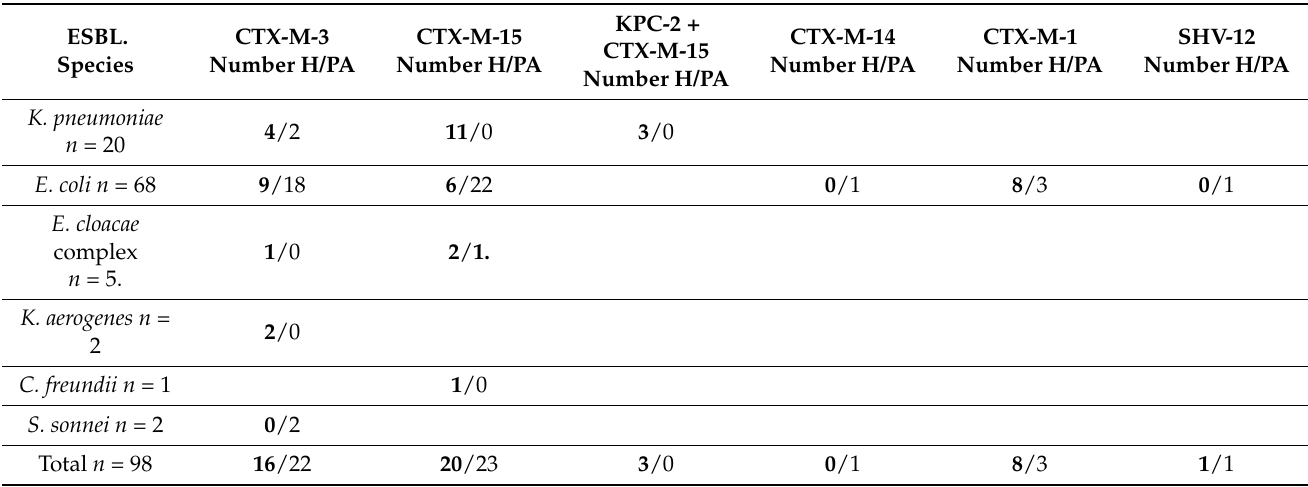
Figure 1. Antimicrobial susceptibility rates in the whole group of Enterobacterales isolates ( n = 98), E. coli ( n = 68), and K. pneumoniae ( n = 20). Abbreviations: CTX, cefotaxime; AUG, amoxicillin/clavulanic acid; CAZ, ceftazidime; FEP, cefepime; FOX, cefoxitine; IMP, imipenem; P/T, piperacillin/tazobactam; TOB, tobramycin, GEN, gentamycin; AMI, amikacin; CIP, ciprofloxacin; LEVO, levofloxacin; SXT, trimethoprim/sulfamethoxazole; R + I—resistant and intermediately susceptible isolates. Table 1. Distribution of extended spectrum beta-lactamases (ESBLs)/carbapenemases according to species and pa- tient’s